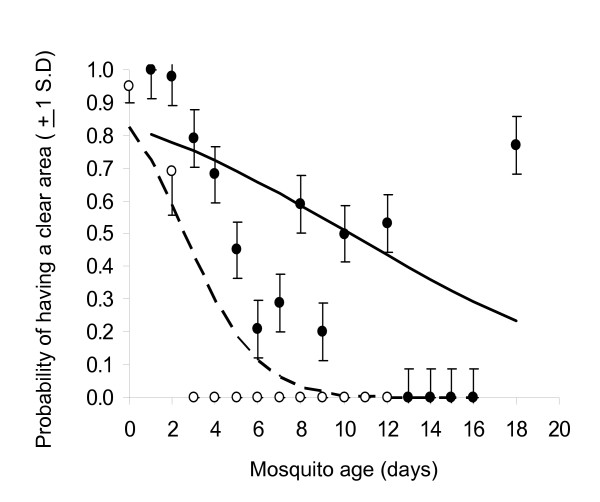
The probability of a male An. gambiae having a clear area around his accessory gland as a function of age and mating history. Open and closed dots are the observed frequency of having a clear area in virgin and once-mated males respectively. The broken line gives the predicted probability of virgin males having a clear area through time, and the solid line gives the predicted probability for once-mated mates.